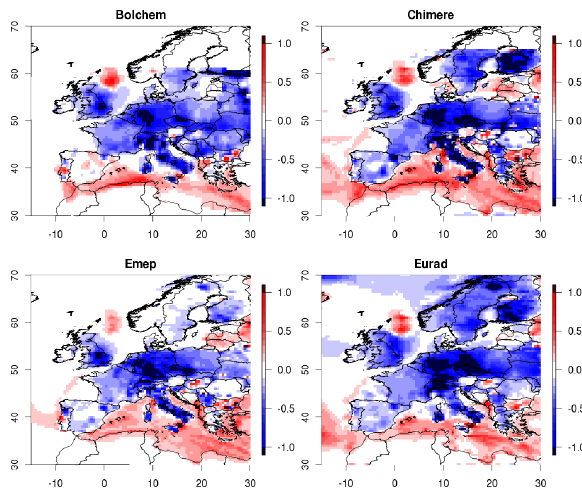
Figure 14 : Trend of NO 2 due to the anthropogenic emission evolution alone (linear least square fit of the difference between the reference run and a simulation with constant – 2007 – emissions), normalised by the interannual meteorological variability (standard deviation of the simulation with constant emissions).